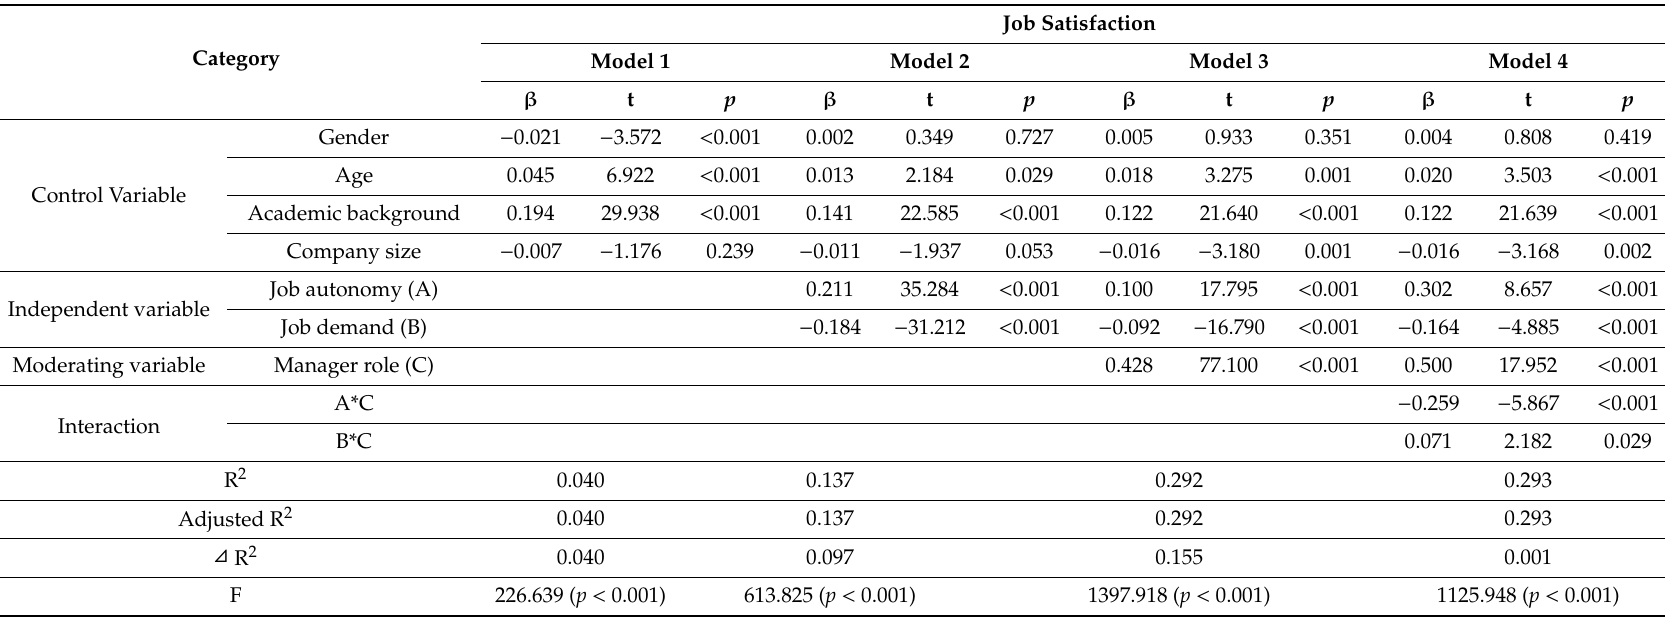
Table 5. The moderating e ff ect of managerial roles in the relationship between job stress and satisfaction in regular employees.